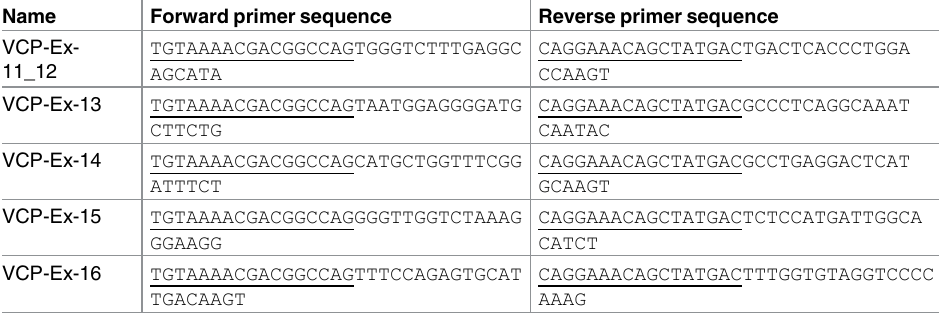
S1 Table. Quantified ubiquitylation